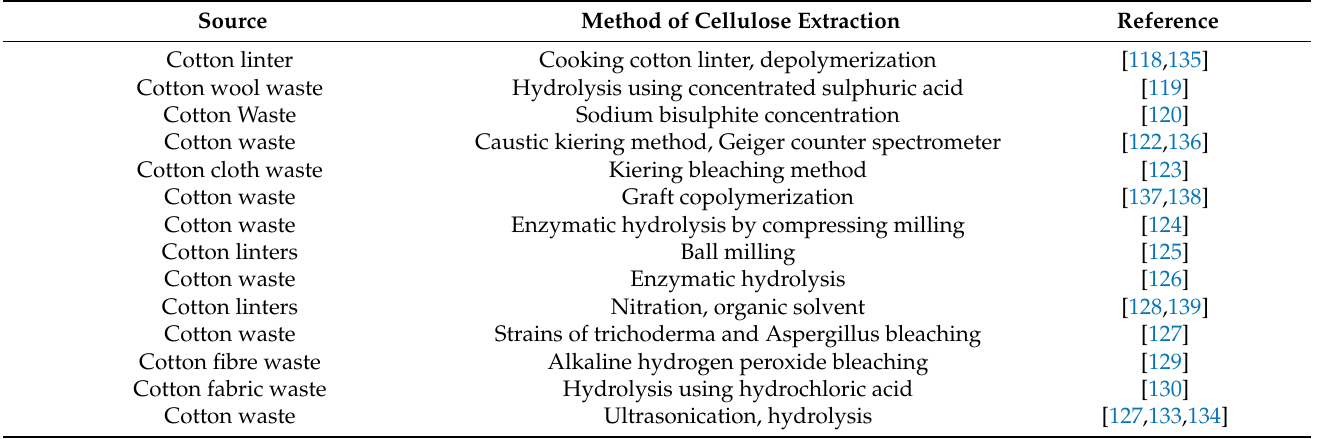
Table 3. Summary of the evolution of cellulose from cotton